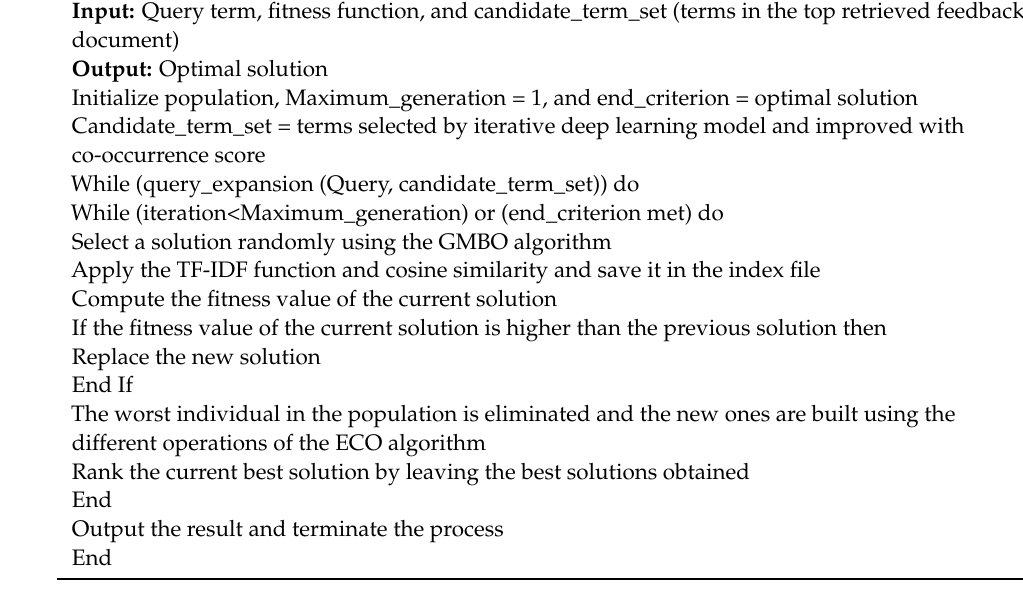
Table 1. Expanded keywords for queries using the hybrid GMBO-ECO algorithm.